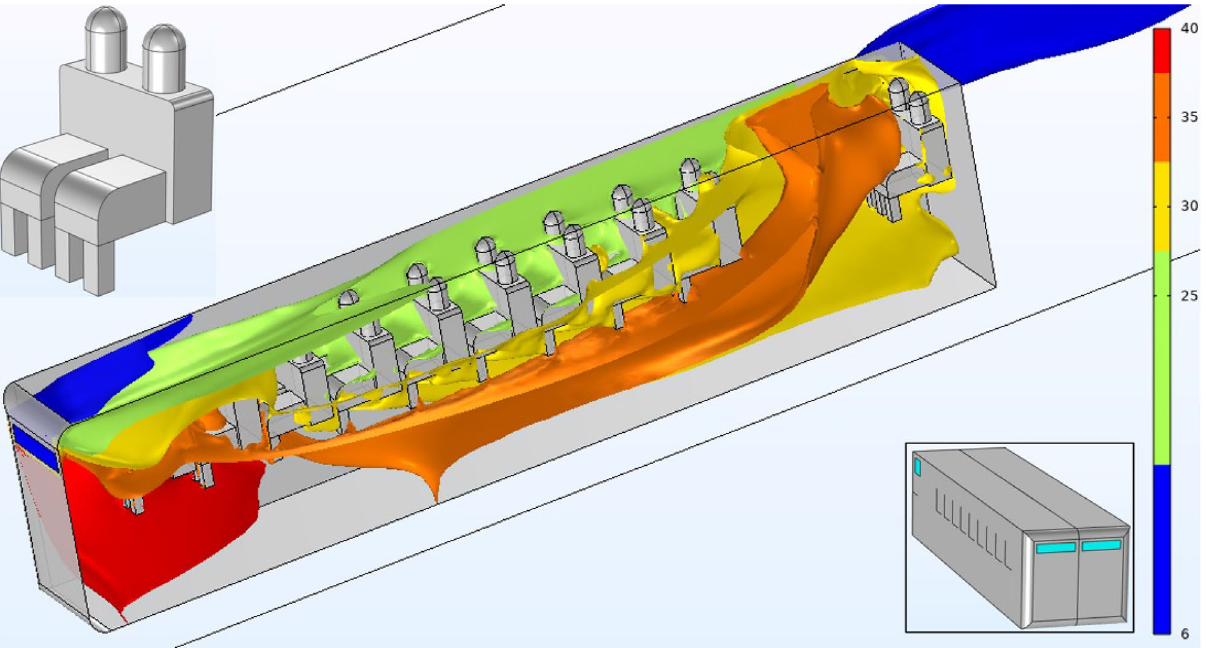
Figure 7. Age of air [s] contours obtained for the FW configuration including manikins. The upper inset shows the details of the manikin’s figure